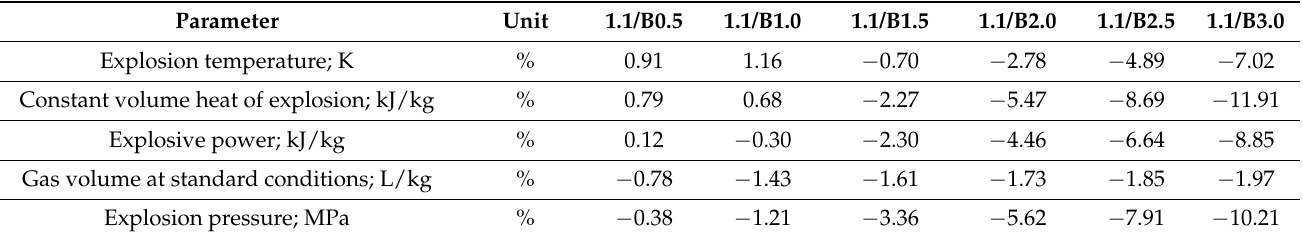
Table 4. Percentage change in the value of individual parameters for EX from variant 1.1 com- pared to ANFO.